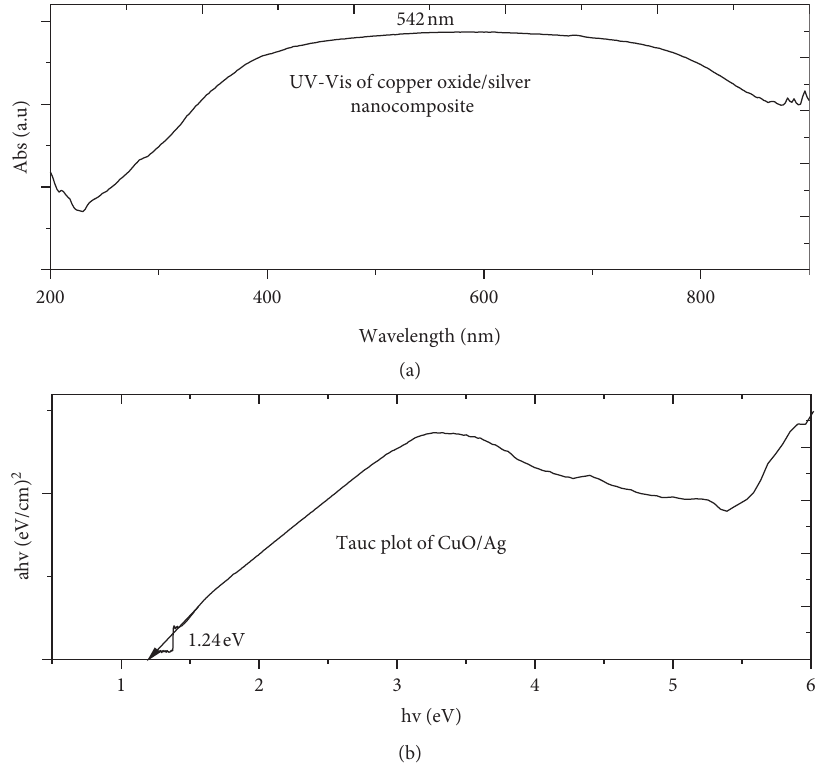
Figure 5: (a) UV-Vis spectrophotometric absorption spectra of CuO/Ag and (b) Tauc plot of